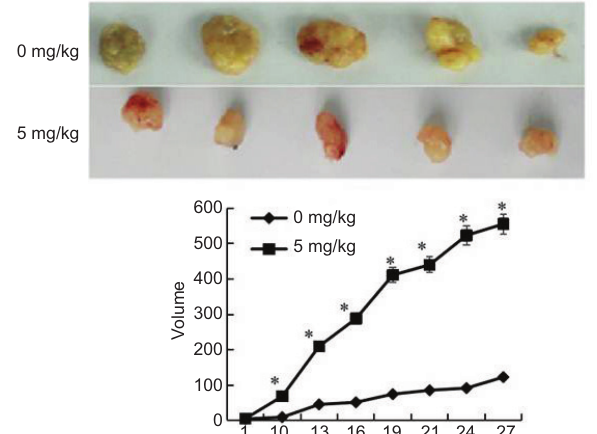
Figure 5: Effect of ligustrazine on growth of tumors. 5 mg/kg of ligustrazine subcutaneously in nude